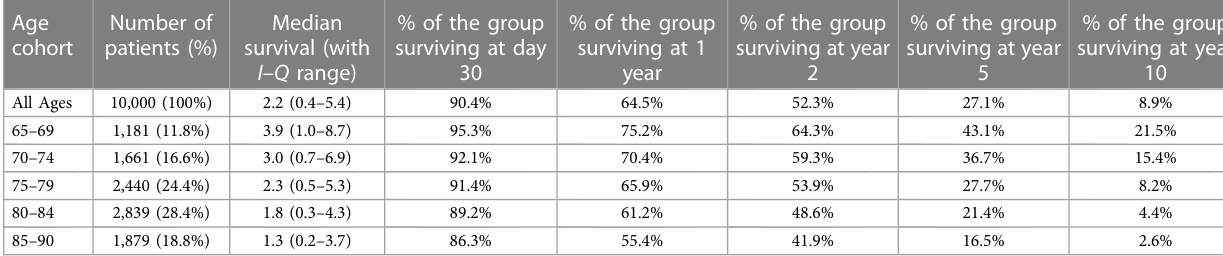
TABLE 3 Median and fractional survival by age, aggregated in 5-year age bins, of rule cohort. Age Number of cohort patients (%)